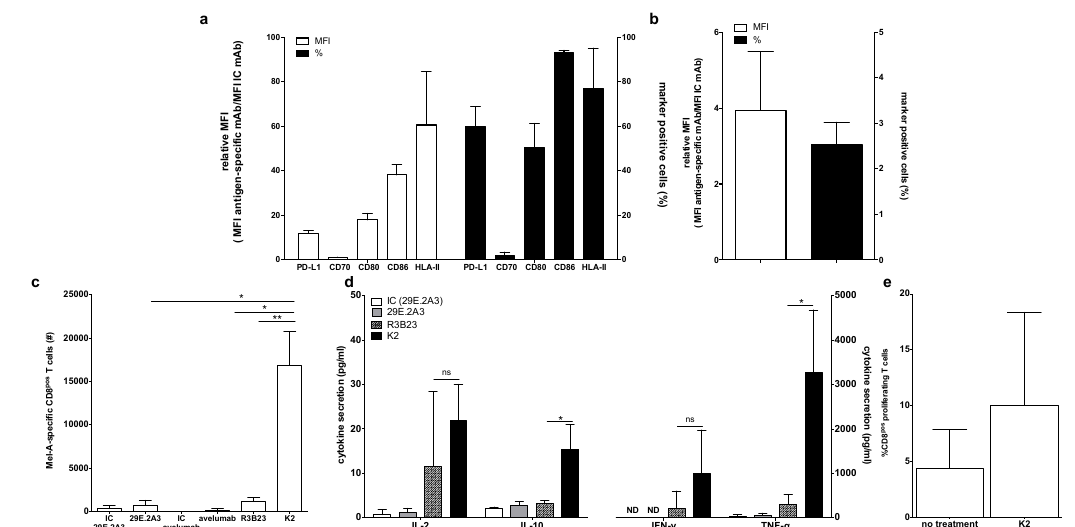
Figure 3. Activation of Melan-A-specific CD8 pos T cells by DC-MEL is enhanced in the presence of sdAb K2. ( a ) Graph showing the percentage of marker positive cells as well as the relative MFI (MFI antigen-specific mAb / MFI IC mAb) for the expression of PD-L1, CD70, CD80, CD86, and HLA-II on DC-MEL. The graph summarizes the results of three independent experiments as mean ± SEM. ( b ) Graph showing the percentage of PD-1 pos cells as well as the relative MFI (MFI antigen-specific mAb / MFI IC mAb) for the expression of PD-1 on T cells. The graph summarizes the results of three independent experiments as mean ± SEM (left). ( c ) Graph showing the number Melan-A-specific T cells after co-culture with DC-MEL in the presence of IC mAbs [IC], anti-PD-L1 mAbs [29E.2A3 and avelumab], sdAb R3B23 [R3B23] or sdAb K2 [K2]. The graph summarizes the results of three independent experiments as mean ± SEM. ( d ) Graph showing the production of IL-2, IL-10, IFN- γ and TNF- α by Melan-A-specific CD8 pos T cells co-cultured with DC-MEL in the presence of sdAb K2 compared to sdAb R3B23. The graph summarizes the results of three independent experiments as mean ± SEM. ( e ) Graph showing the percentage of CD8 pos proliferating T cells co-cultured with DC-MEL in the presence of sdAb K2. The graph summarizes the results of two independent experiments as mean ± SEM. The number of asterisks in the figures indicates the statistical significance as follows: * p < 0.05; ** p < 0.01 and *** p < 0.001.